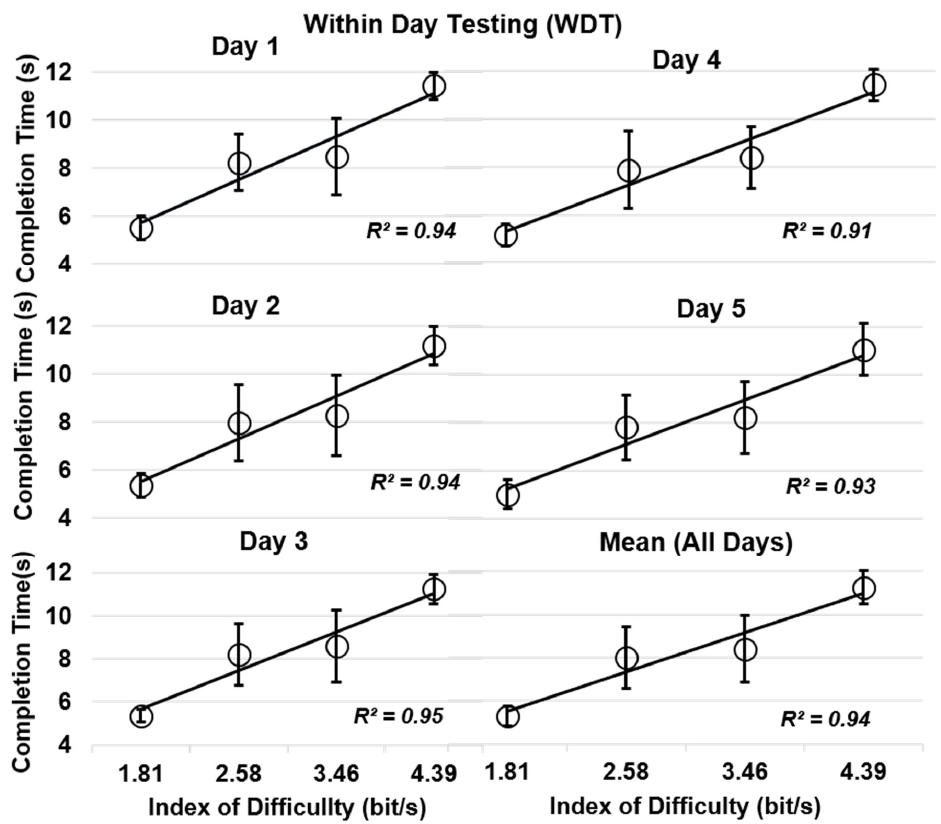
Figure 4. Relationship between completion time (CT; mean ± standard deviation) and index of difficulty for within-day testing (WDT). Table 4. Comparison of completion time with respect to performance metrics for between-day testing (BDT), WDT, and combined-day testing (CDT).